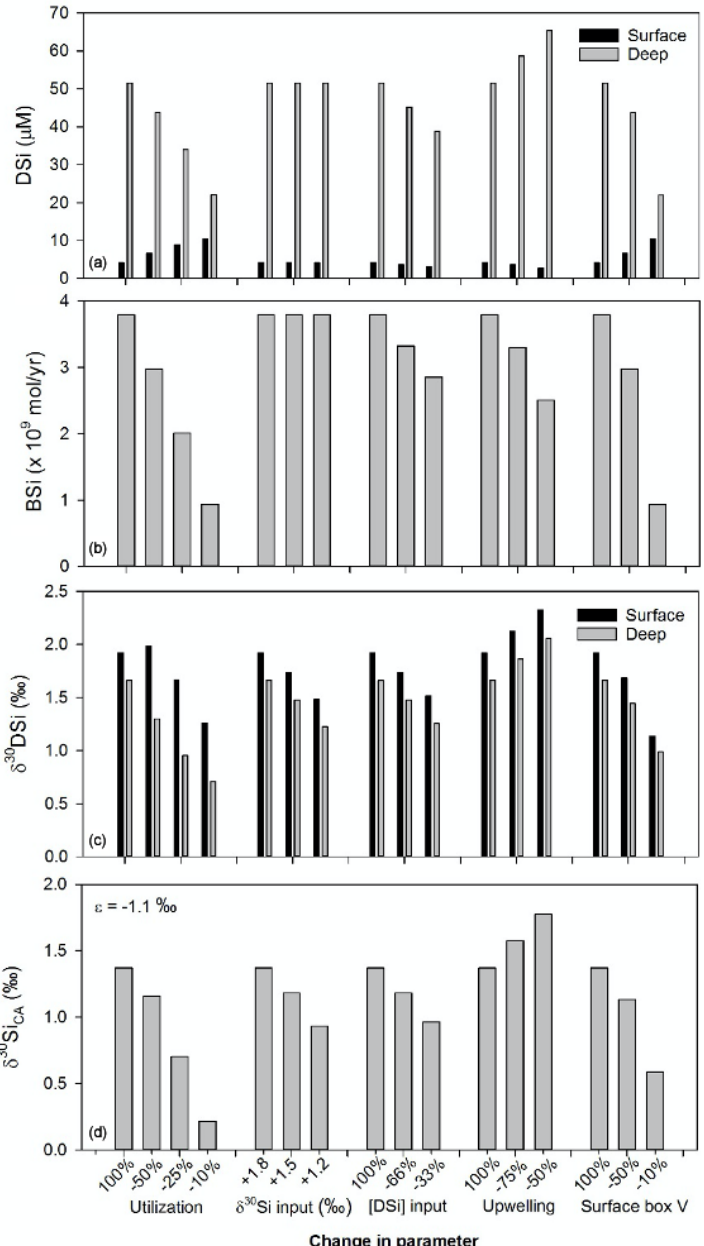
Figure 3. Model output results from the two-box model experiments. Each experiment shows the impact on different output parameters from changing one aspect of the model configuration (biological utilization by dominant diatom species, isotopic and [DSi] composition of input waters reflecting a change in SO waters, upwelling strength, and the volume of the surface box): (a) seawater [DSi] in the surface and deep box; (b) opal production by dominant species; (c) the isotopic composition of DSi in the surface and deep box; and (d) the isotopic composition of the pelagic diatoms, C. radiatus and A. curvatulus ( δ 30 Si CA